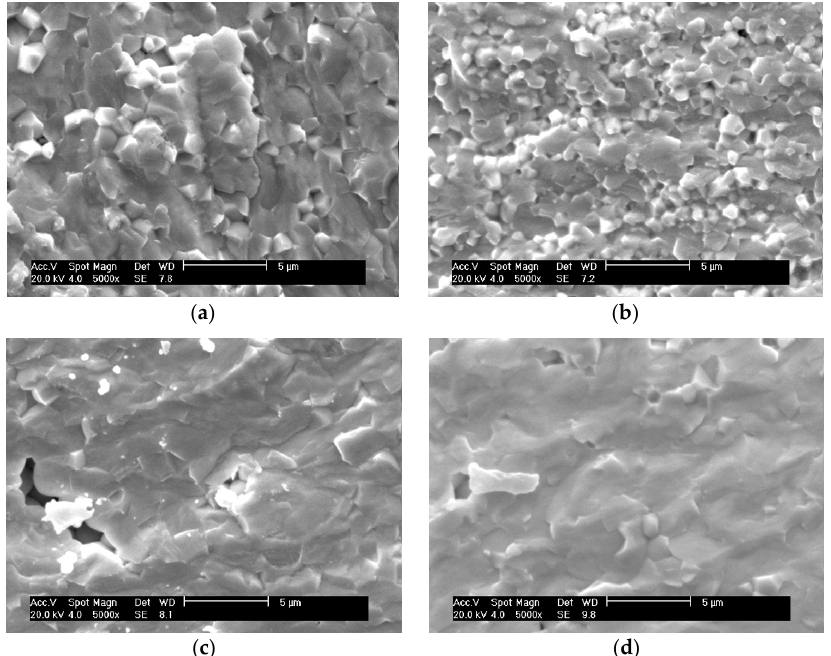
Figure 5. SEM images of the fractured surfaces of PZTN composite ceramics sintered at 1260 °C for 2 h with ( a ) x = 0, ( b ) x = 0.01, ( c ) x = 0.03, and ( d ) x =